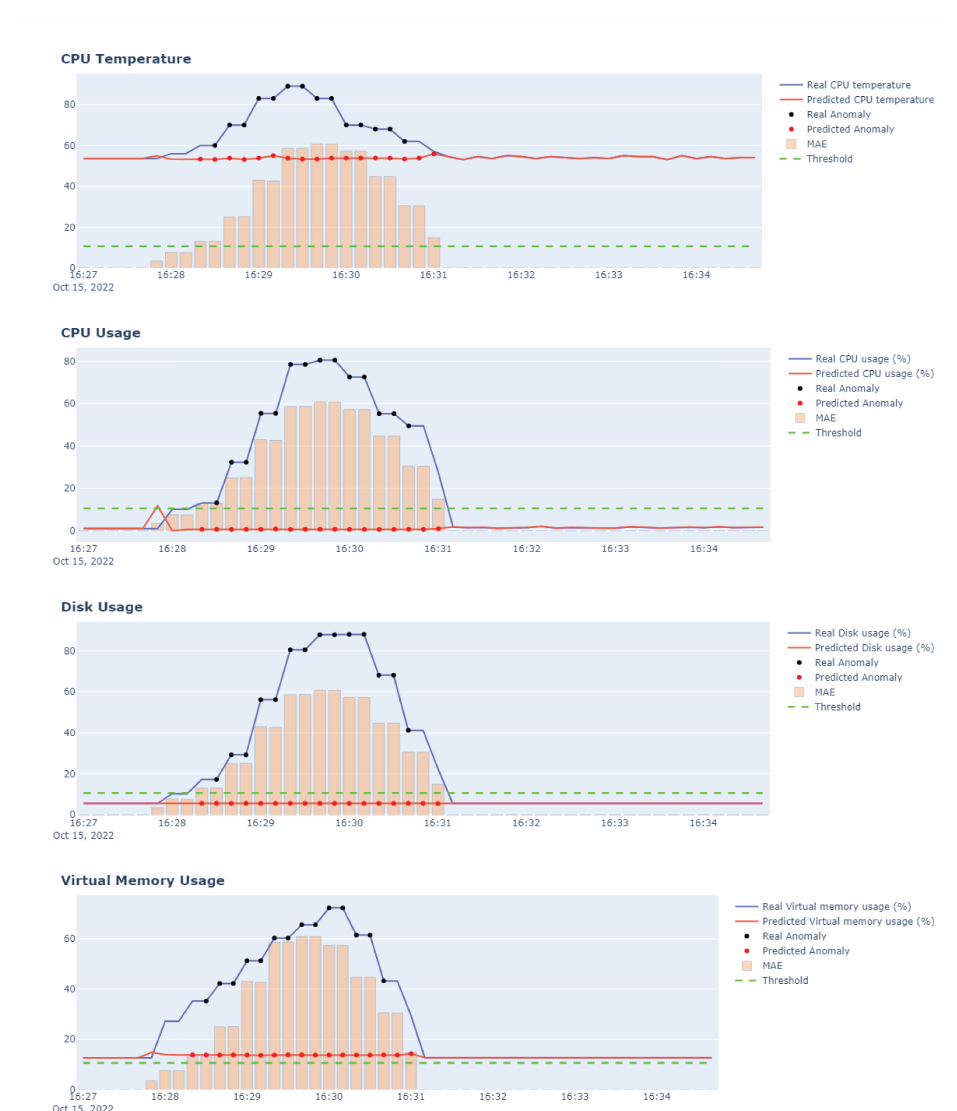
Figure 17. The real and reconstructed or predicted time series of the proposed model with real and predicted anomaly